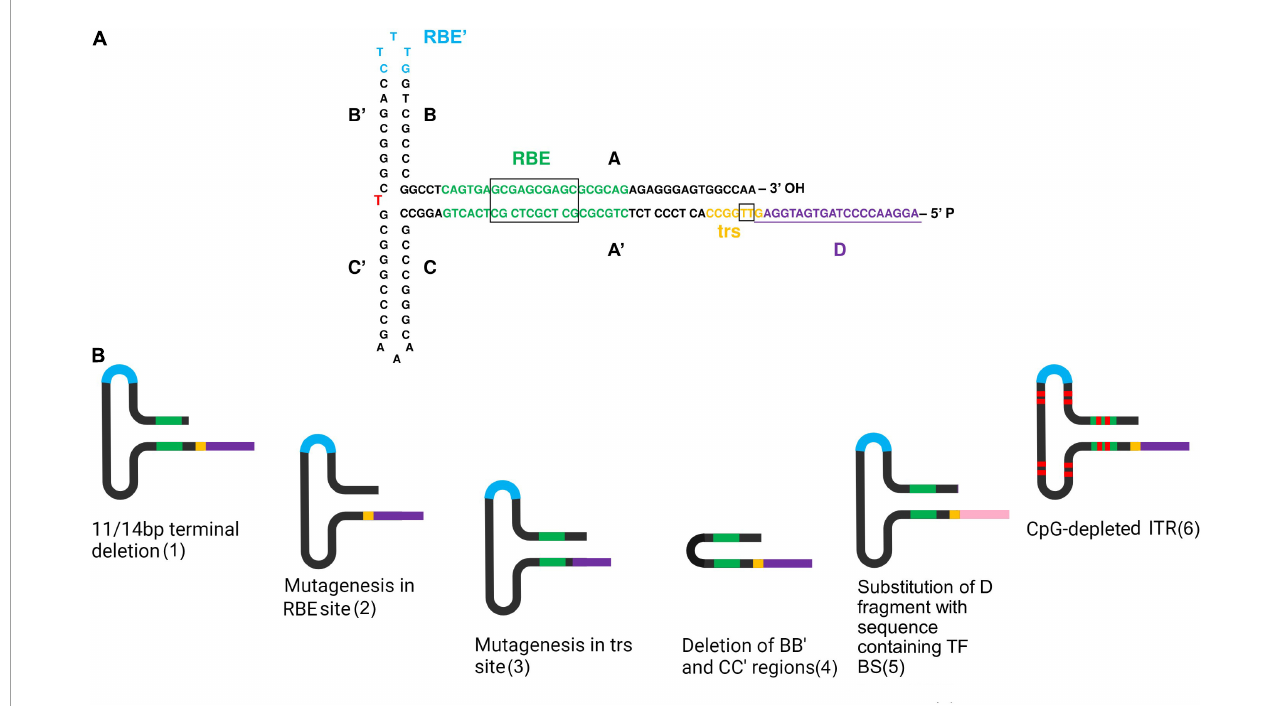
FIGURE1 Directed structure modification of ITRs. (A) Detailed scheme of the ITR structure in FLIP orientation. A red letter indicates a nucleotide changing in different orientations. This scheme was created based on a figure from (110). (B) Some variants of ITR modification. In order from left to right: 1—11/14 bp terminal deletion does not affect AAV viability, since it is rapidly repaired during following second-strand DNA synthesis; 2—mutagenesis in the RBE site reduces binding with Rep proteins. Dinucleotide substitutions in the core 10 bp sequence decreased binding affinity over 10-fold and single-nucleotide substitution up to fivefold (43); 3—mutagenesis in the trs site decreases Rep nicking. The greatest effect of 3–10-fold Rep nicking reduction has been discovered due to mutagenesis in the core 7 bp site representing two thymines. Mutagenesis in the trs flanking regions has similarly been observed to reduce Rep nicking, but only by 20–50% (44); 4—the deletion of the BB’ and CC’ regions reduces viral productivity by 75%, meanwhile, provides an increased level of transgene expression in vitro and in vivo , reaching up to a 6.6-fold increase in some cases, compared to wild-type ITRs (47); 5—substitution of the entire D region of the 5 (cid:48) ITR by a non-AAV substitute sequence containing transcription factor binding sites (TF BS) led to increased transduction efficiency, possibly due to increased transgene expression (110). Pink color indicates the sequence containing TF BS 6—CpG depleted ITRs are stable in bacterial passaging, thus facilitating AAV production (54). Red markers used for a schematic depiction of guanine and cytosine substitutions to adenine and thimine. In both pictures, the colors indicate the main structures of ITRs. Black—AA’, BB’, CC’ regions; green—RBE site with the core sequence in the black box; blue—RBE’ site; yellow—trs site with two thymines in the black box between which a single-strand break occurs; purple—D-region containing one nucleotide from trs site underlined on (A) . Created with BioRender.com.